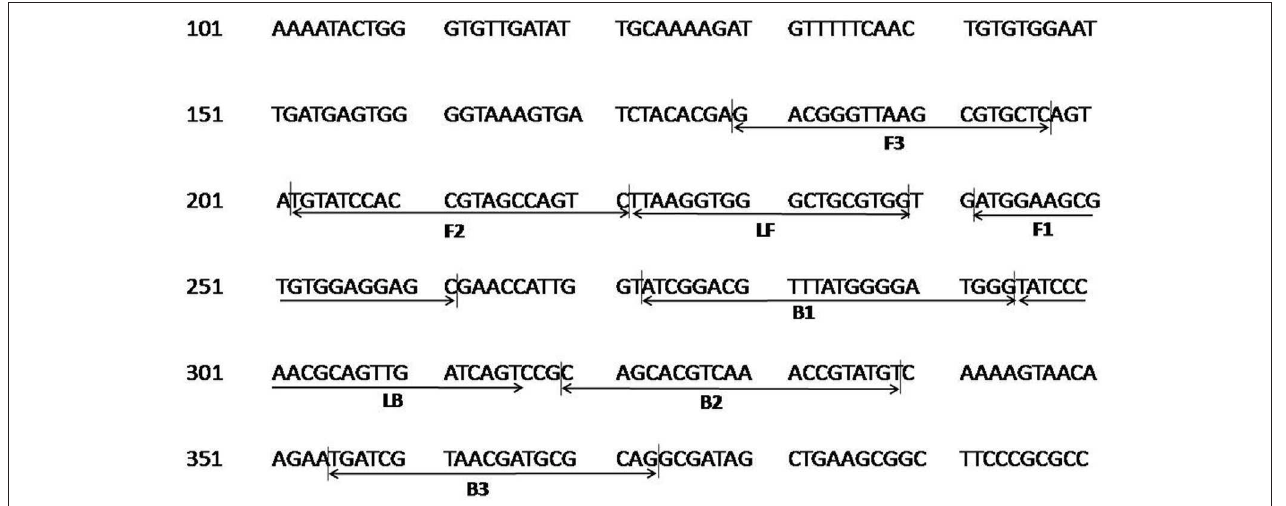
Frontiers in Cellular and Infection Microbiology |